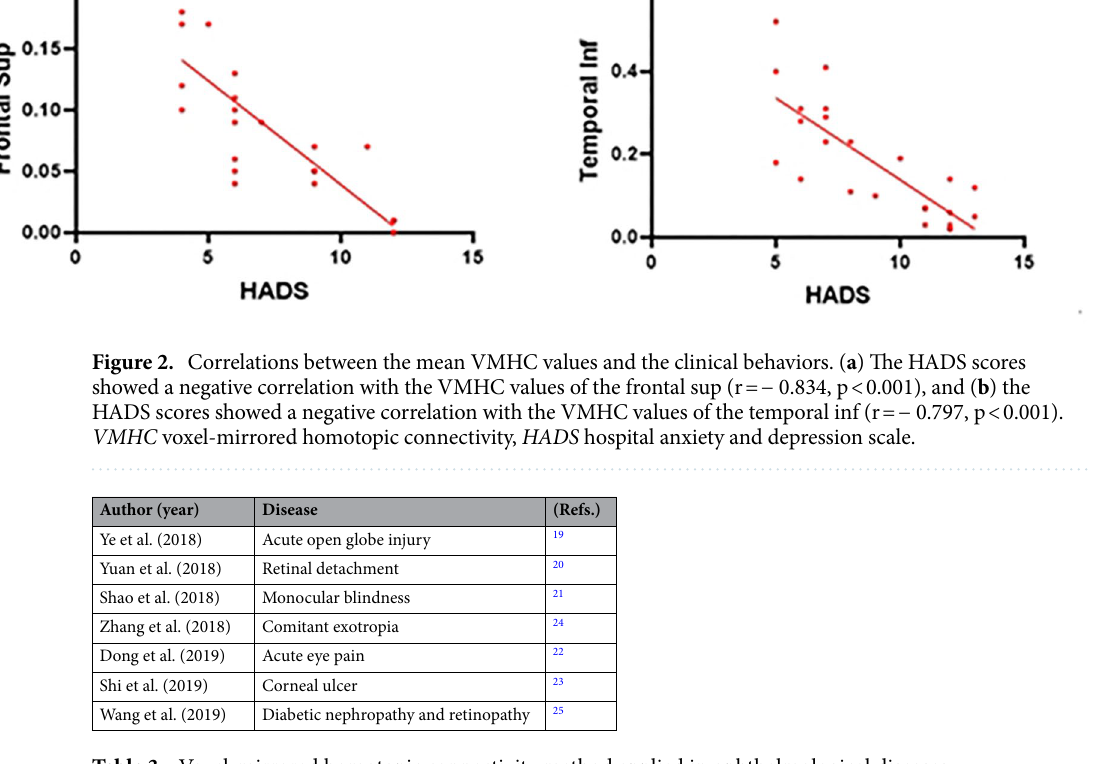
Table 3. Voxel-mirrored homotopic connectivity method applied in ophthalmological